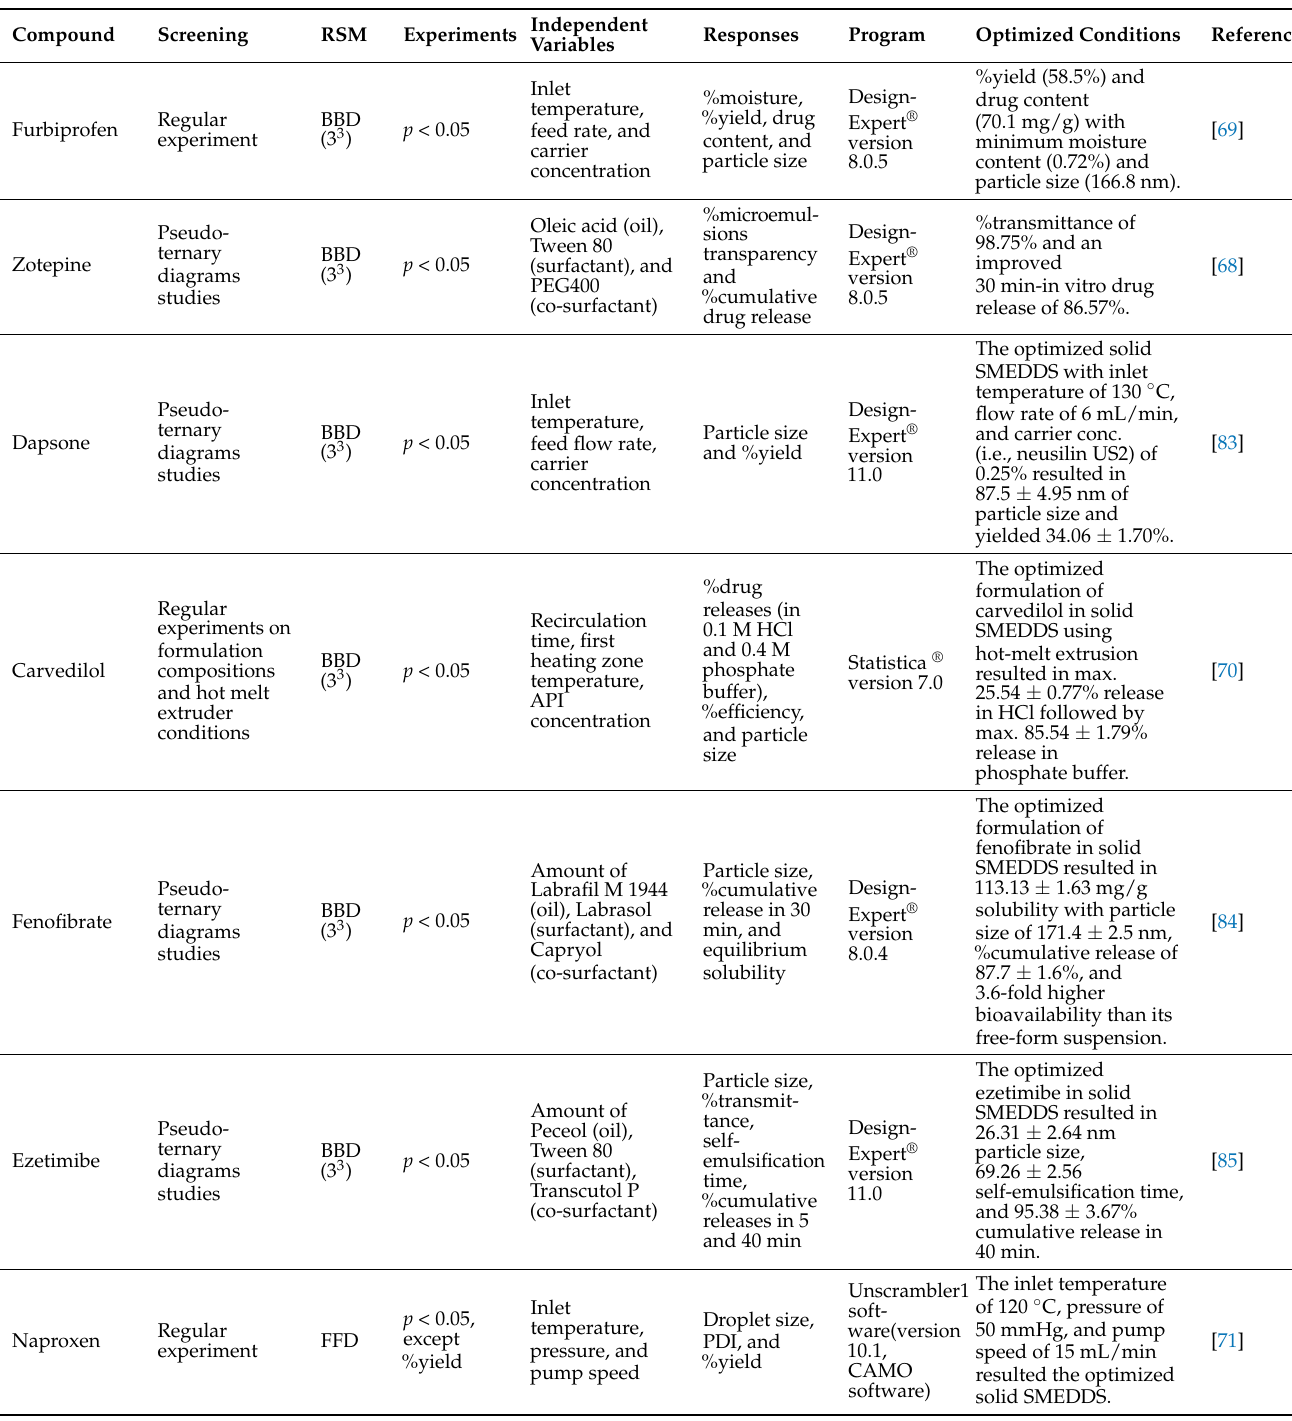
Table 6. List of the SMEDDS developments along with the applied response surface methodology (RSM) of Box-Behnken design